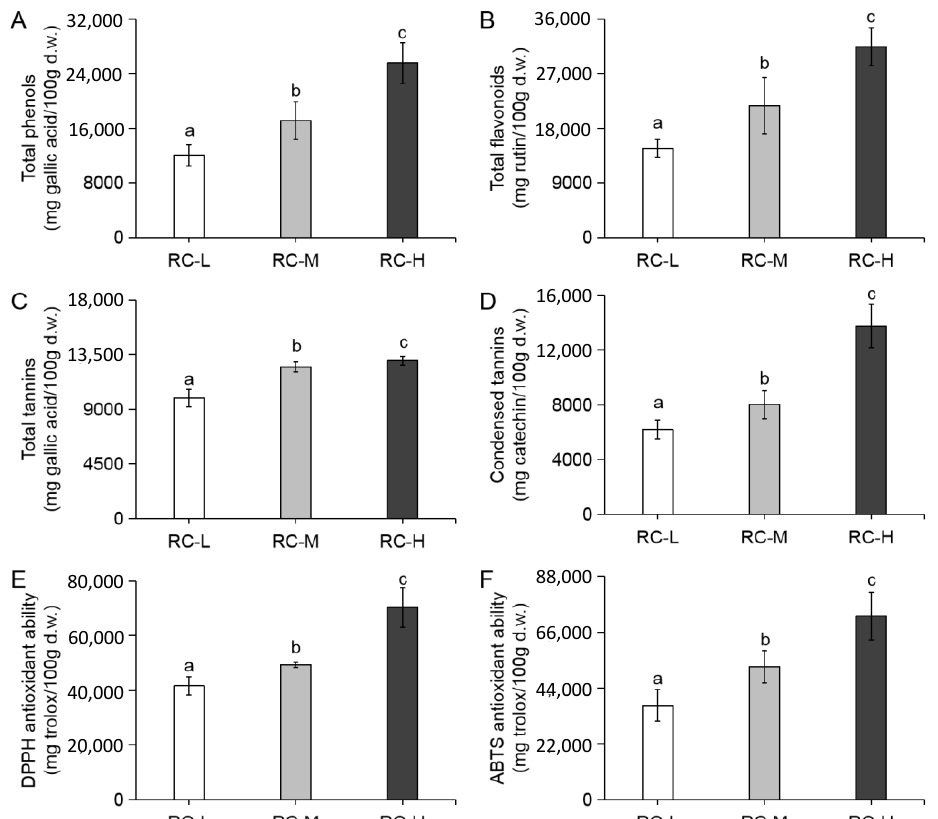
Figure 3. Characteristics of phenolic components and antioxidant capacity for rhizomes of Rhodiola crenulata (RC-L, RC-M, and RC-H) from different altitudes (3933, 4249 and 4531 m), respectively. ( A ): Total phenols; ( B ): Total flavonoids; ( C ): Total tannins; ( D ): Condensed tannins; ( E ): DPPH antioxidant ability (DPPH is a abbreviation of 2,2-diphenyl-1-picrylhydrazyl); ( F ): ABTS antioxidant ability (ABTS is a abbreviation of (2,2’-azino-bis(3-ethylbenzothiazoline-6-sulphonic acid). Gallic acid was used as a standard for Total phenols and Total tannins. Rutin and Catechin were used as standards for Total flavonoids and Condensed tannins, respectively. Trolox was used as a standard for DPPH and ABTS antioxidant ability. Results are presented as the mean ± SD of six independent experiments ( n = 6) and are expressed as mg standard per 100 g d.w. of plant materials. In each column, different letters (a, b, c) mean significant differences between two groups ( p < 0.05) found via a t -test. Note: Rhodiola crenulata samples are presented according to the ascending order of altitude from left to right.